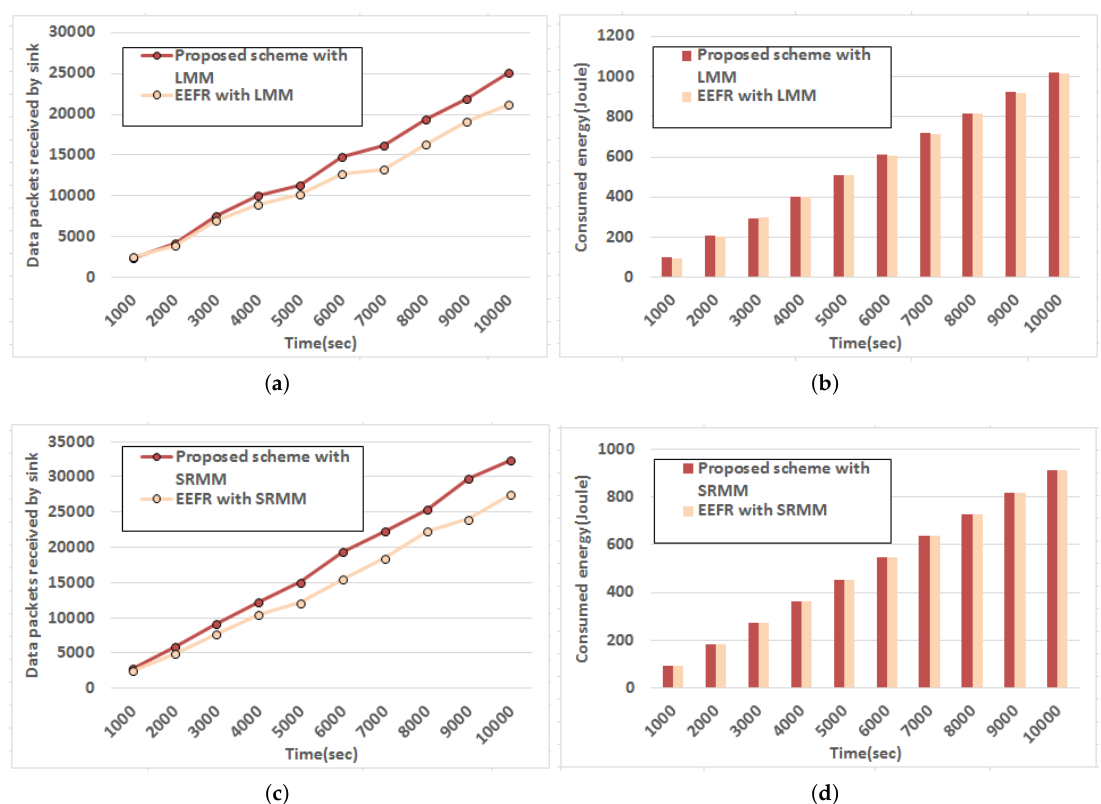
Figure 10. Performance evaluation of the proposed routing strategy with respect to time. ( a ) Variation of data packets received by sink with time following Line Mobility Model (LMM). ( b ) Variation of energy consumption with varying time following LMM. ( c ) Variation of data packets received by sink with time following Smooth Random Mobility Model (SRMM). ( d ) Variation of energy consumption with varying time following